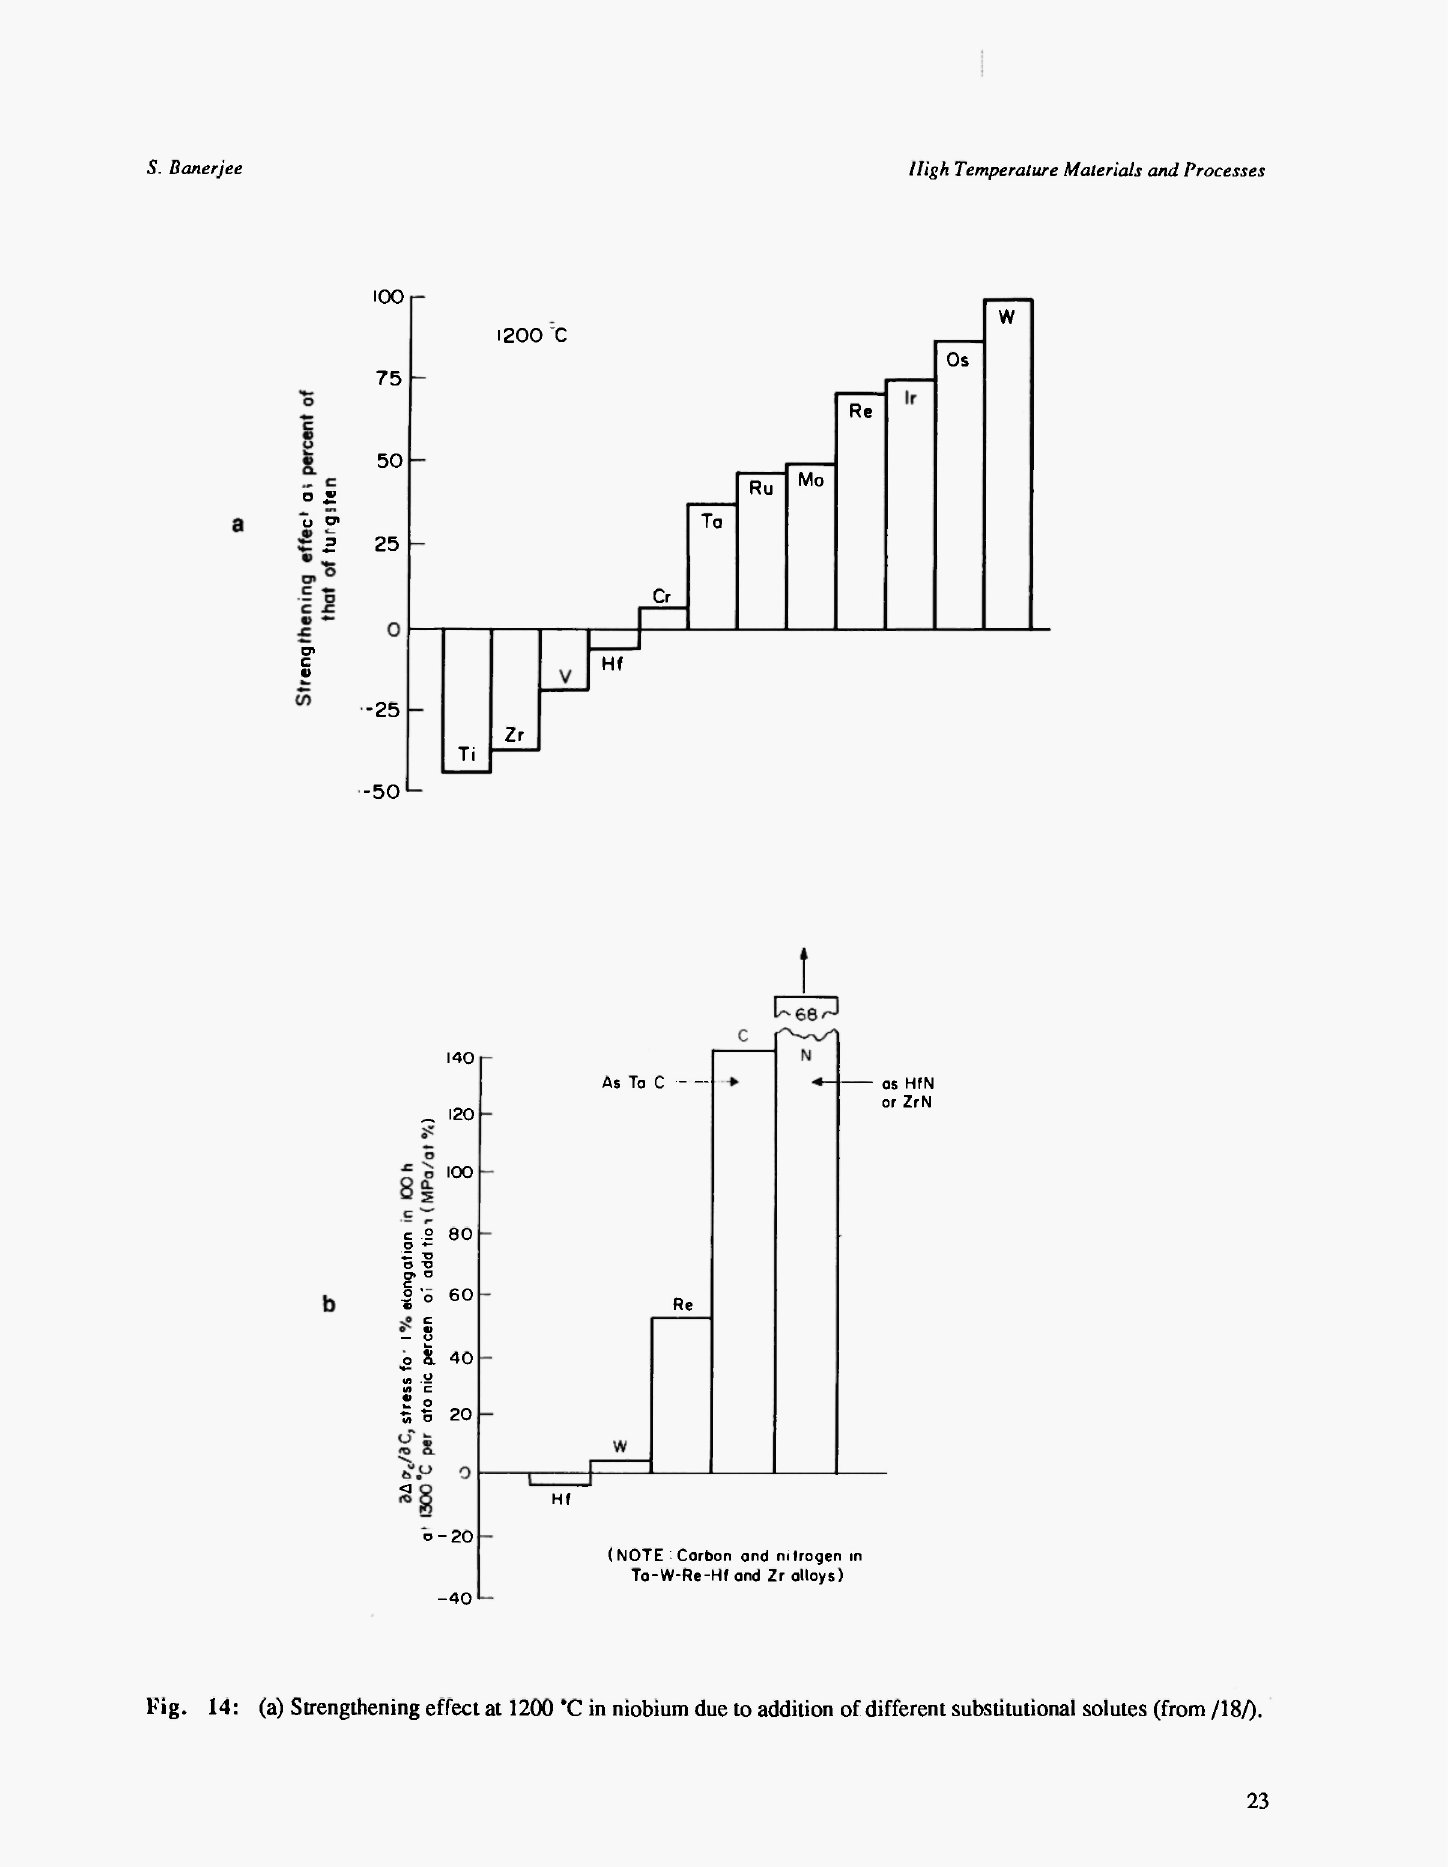
(NOTE Carbon and nitrogen in Ta-W-Re-Hf and Zr alloys)